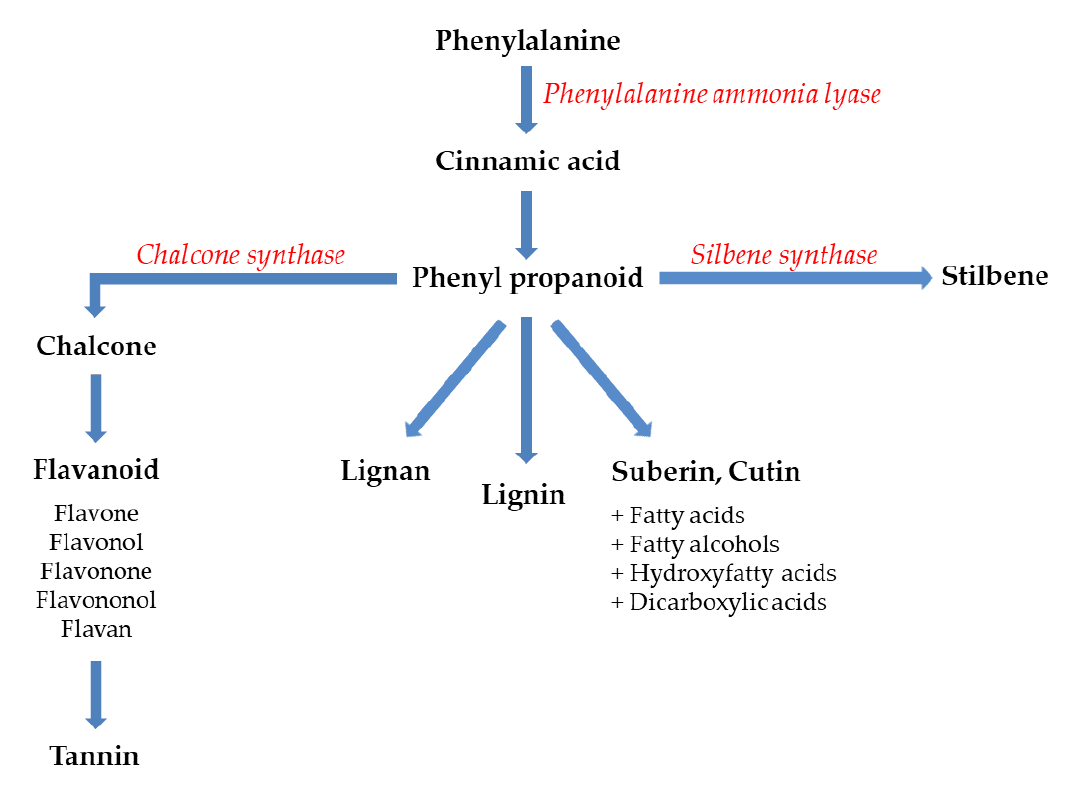
Figure 1. Schematic representation of flavonoids, tannins, stilbenes, lignans, lignins, suberins and cutins from phenylalanine.